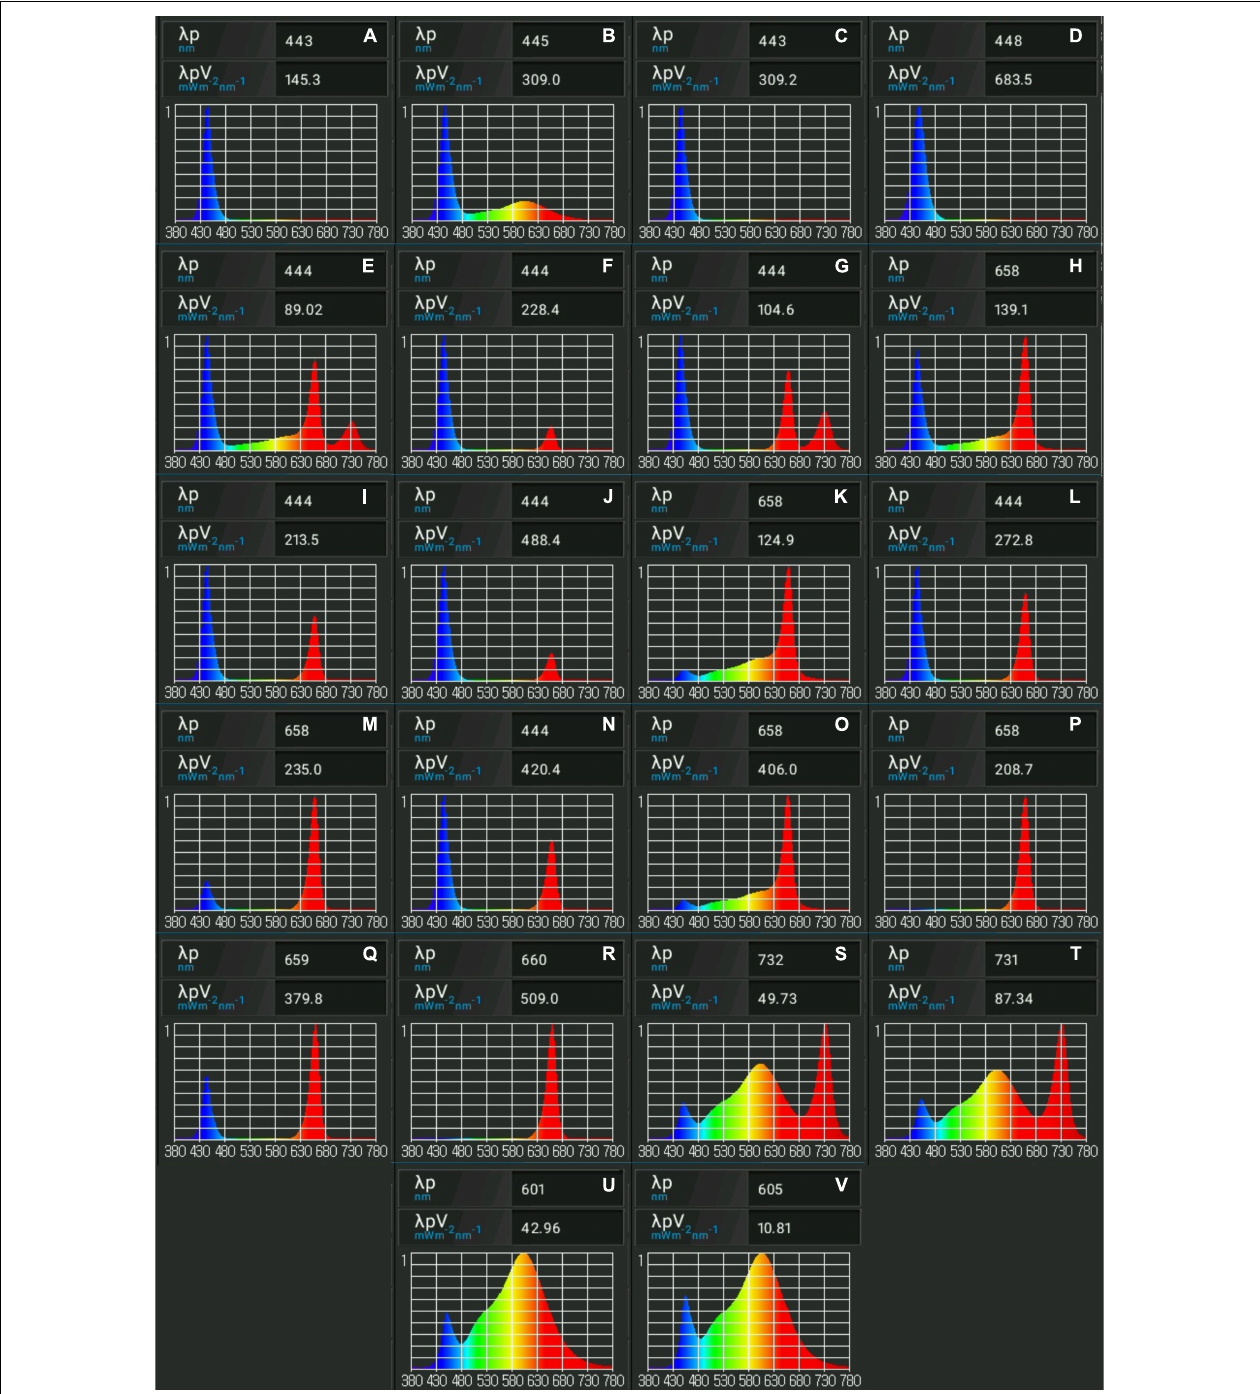
FIGURE 3 | Spectral analyses of light treatments from the initial experiment. Images indicate relative amounts of fluencies emitted per treatment. Light spectra presented were obtained using Li-Cor LI-180 spectrometer. Presented are (A) 25 µ mol/m 2 /s B + 25 µ mol/m 2 /s W, (B) 50 µ mol/m 2 /s B + 50 µ mol/m 2 /s W, (C) 50 µ mol/m 2 /s B, (D) 100 µ mol/m 2 /s B, (E) 12.5 µ mol/m 2 /s R + 12/5 µ mol/m 2 /s B + 12.5 µ mol/m 2 /s Fr + 12.5 µ mol/m 2 /s W, (F) 12.5 µ mol/m 2 /s R + 37.5 µ mol/m 2 /s B, (G) 16.67 µ mol/m 2 /s R + 16.67 µ mol/m 2 /s B + 16.67 µ mol/m 2 /s Fr, (H) 25 µ mol/m 2 /s R + 25 µ mol/m 2 /s B + 25 µ mol/m 2 /s Fr + 25 µ mol/m 2 /s W, (I) 25 µ mol/m 2 /s R + 25 µ mol/m 2 /s B, (J) 25 µ mol/m 2 /s R + 75 µ mol/m 2 /s B, (K) 25 µ mol/m 2 /s R + 25 µ mol/m 2 /s W, (L) 33.33 µ mol/m 2 /s R + 33.33 µ mol/m 2 /s B + 33.33 µ mol/m 2 /s Fr, (M) 37.5 µ mol/m 2 /s R + 12.5 µ mol/m 2 /s B, (N) 50 µ mol/m 2 /s R + 50 µ mol/m 2 /s B, (O) 50 µ mol/m 2 /s R + 50 µ mol/m 2 /s W, (P) 50 µ mol/m 2 /s R, (Q) 75 µ mol/m 2 /s R + 25 µ mol/m 2 /s B, (R) 100 µ mol/m 2 /s R, (S) 25 µ mol/m 2 /s W + 25 µ mol/m 2 /s Fr, (T) 50 µ mol/m 2 /s W + 50 µ mol/m 2 /s Fr, (U) 50 µ mol/m 2 /s W, and (V) 100 µ mol/m 2 /s